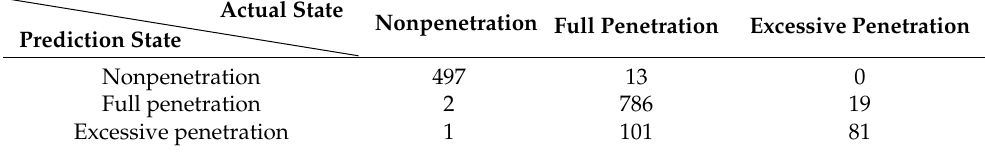
Table 7. Prediction results of each penetration state by using SVM.